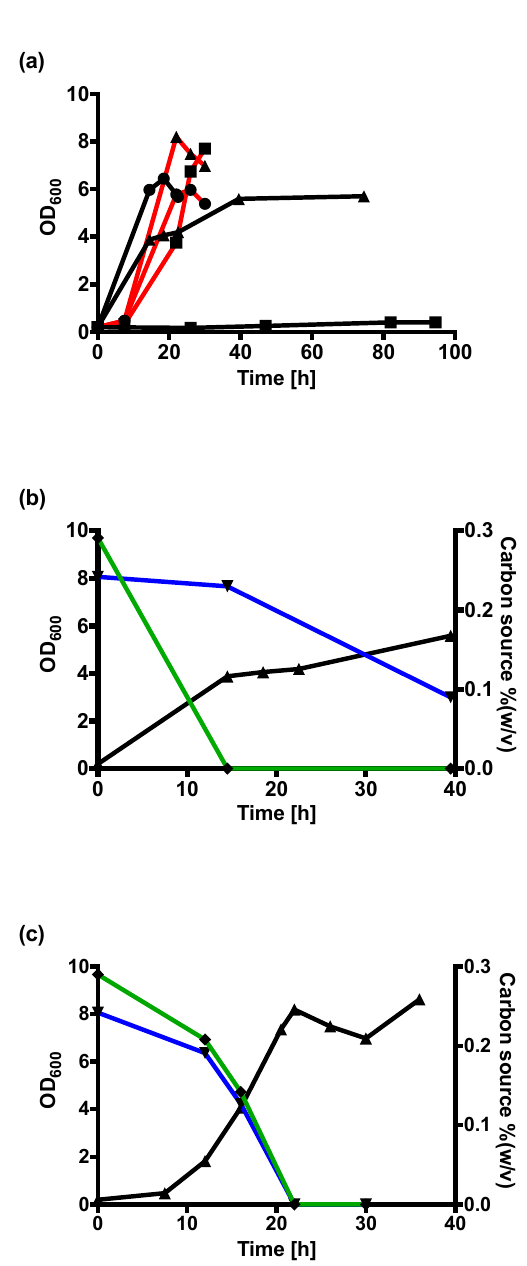
Figure 3. ( a ) Growth curves of wild-type (black lines) and variant v6C6 (red line) in mineral salts medium (MSM) with 0.59% ( w / v ) sodium gluconate (circle), MSM with 0.50% ( w / v ) glycerol (square), and MSM with 0.30% ( w / v ) sodium gluconate and 0.25% ( w / v ) glycerol (triangle). ( b , c ) The growth curve (black line; triangle) and concentrations of sodium gluconate (green line, diamond) and glycerol (blue line; inverted triangle) in the culture media determined using HPLC for C. necator H16 wild-type (b) and v6C6 (c) cultivated in MSM with 0.30% ( w / v ) sodium gluconate and 0.25% ( w / v ) glycerol.